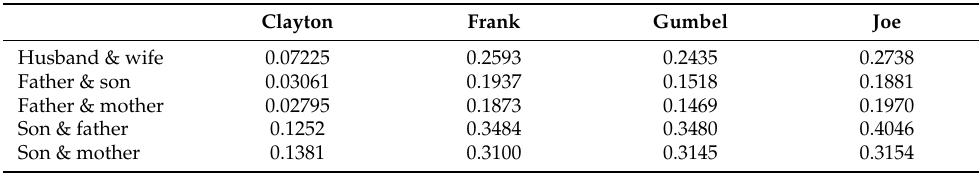
Table 7. Kendall’s tau correlation coefficient corresponding to MCMC α dependence parameter estimates. Clayton Frank Gumbel